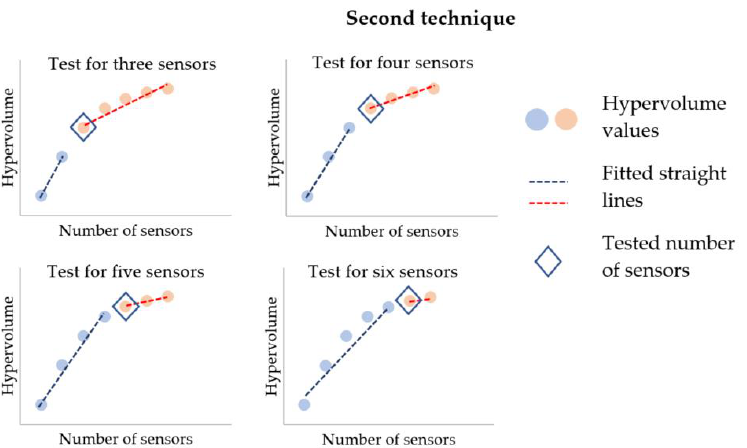
Figure 4. Determination of the optimal number of sensors based on the evolution of the hypervolume using the second technique.